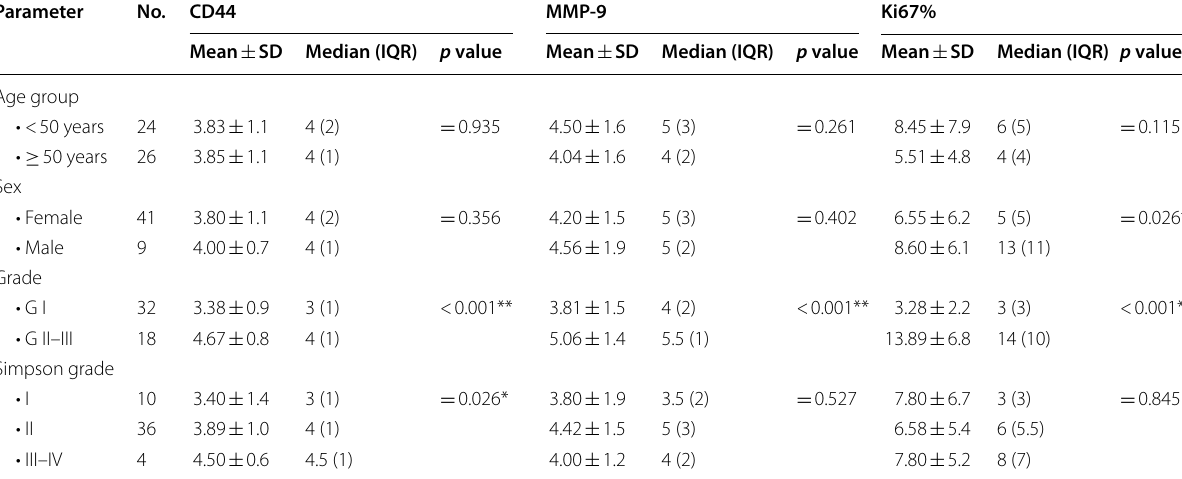
* significant p value < 0.05, ** significant p value <